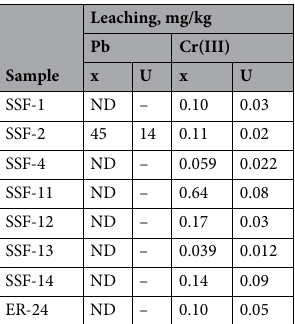
Table 6. Results of research on the leaching of elements in SBR and EPDM rubber granules. SSF SBR granulate sample from a sport field, ER EPDM granulate sample provided by the recycler, x average value, U expanded uncertainty value with a confidence level of 95% and coverage factor k = 2, ND not detected.